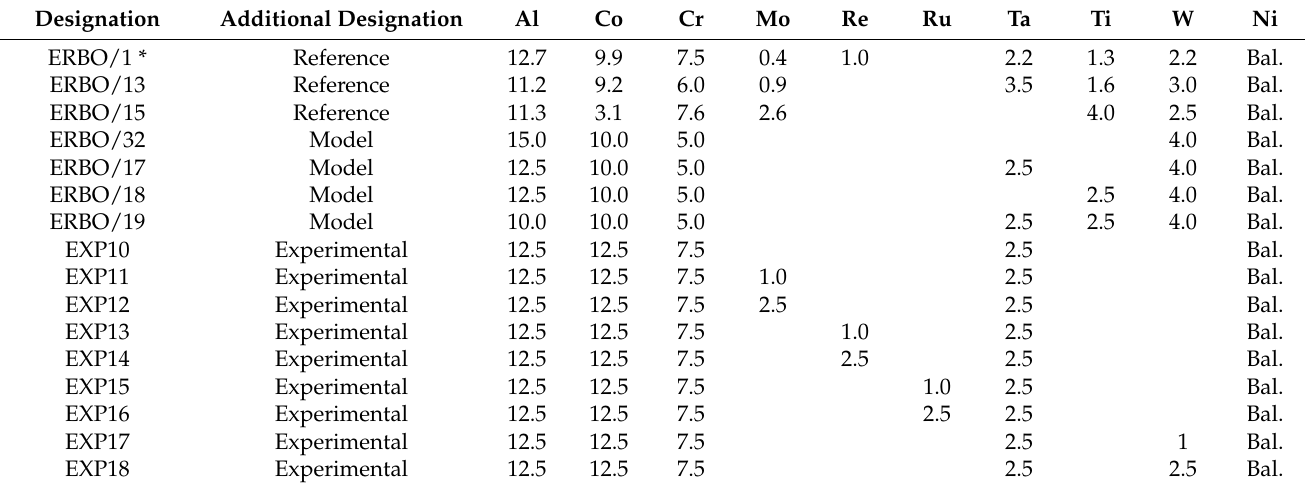
Table 1. Chemical composition of the investigated alloys in at.-%. * ERBO/1 additionally contains 0.03 at.-% Hf.